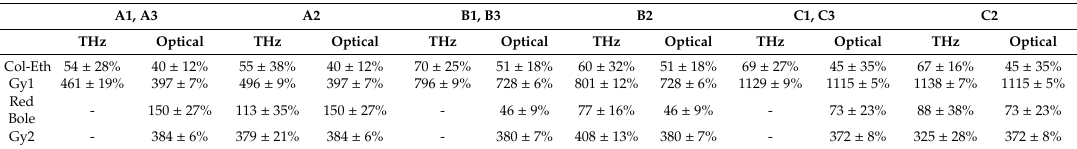
Table 2. THz estimation and optical measurement of layer thickness (in microns) of six areas covered by Colophony-based varnish.